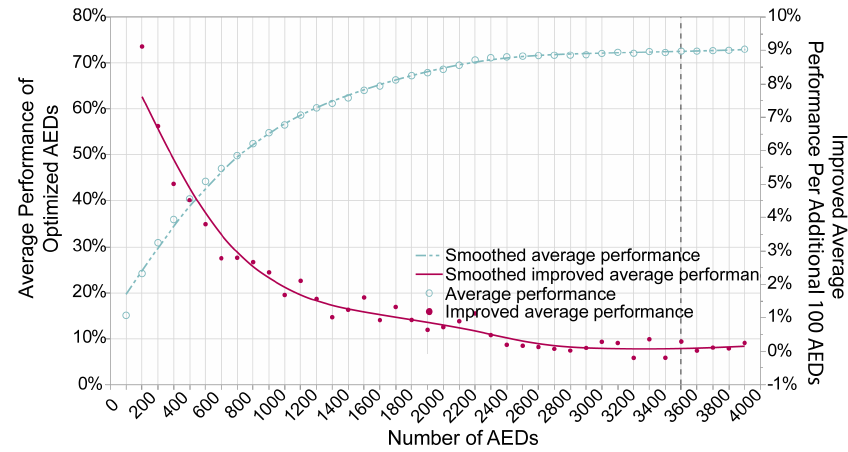
Figure 8. Cost − Coverage Increment